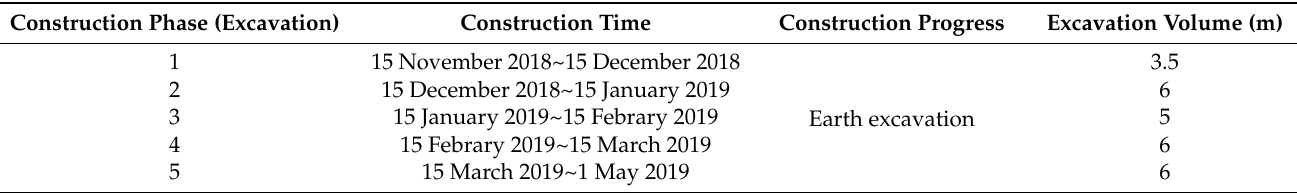
Table 4. Excavation time of each stage of the foundation pit.